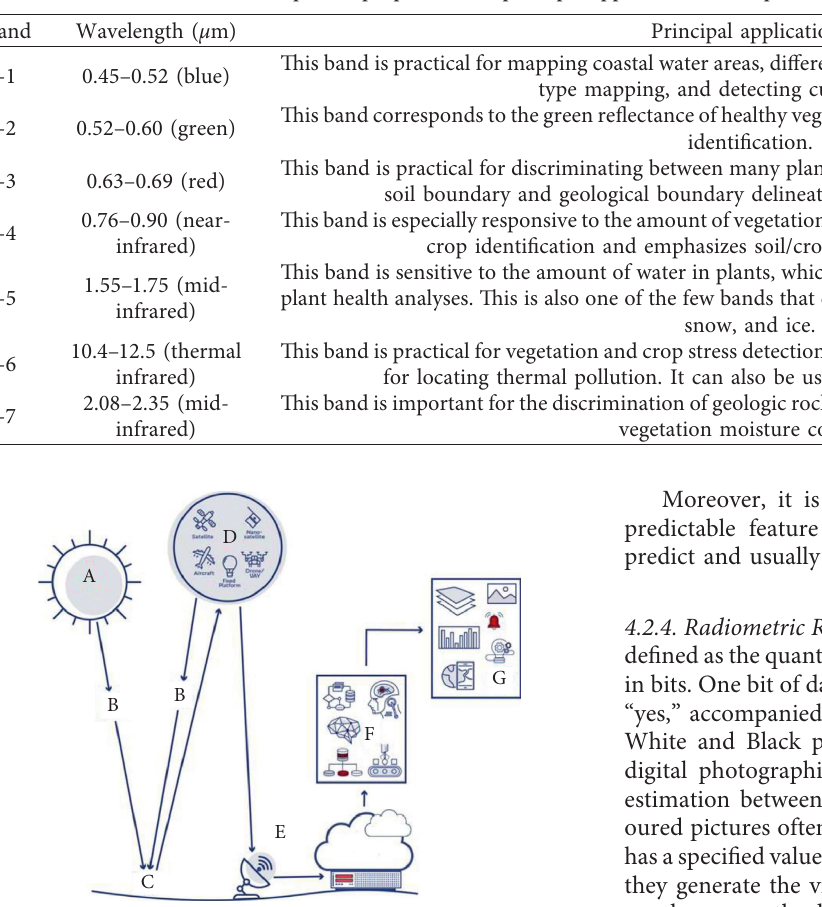
Figure 1: The geo-spatial analytics process